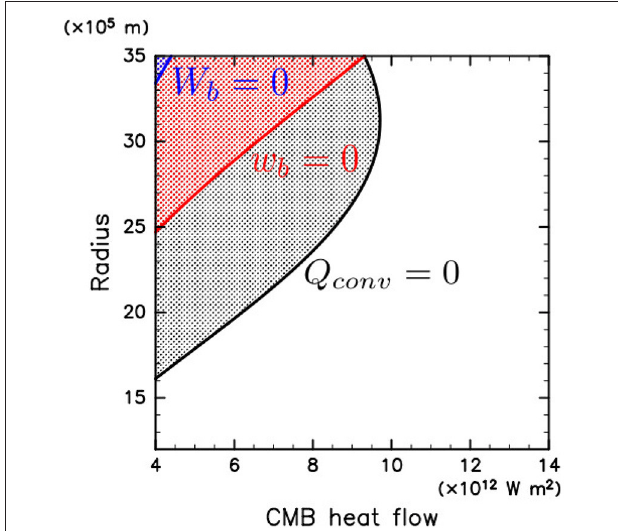
FIGURE 5 | Possible stable layer thickness as a function of CMB heat flow. The blue and red lines indicate the thickness of the minimum and maximum stable layers, respectively. The black line shows the thickness of a stable layer estimated by thermal convective flux only.